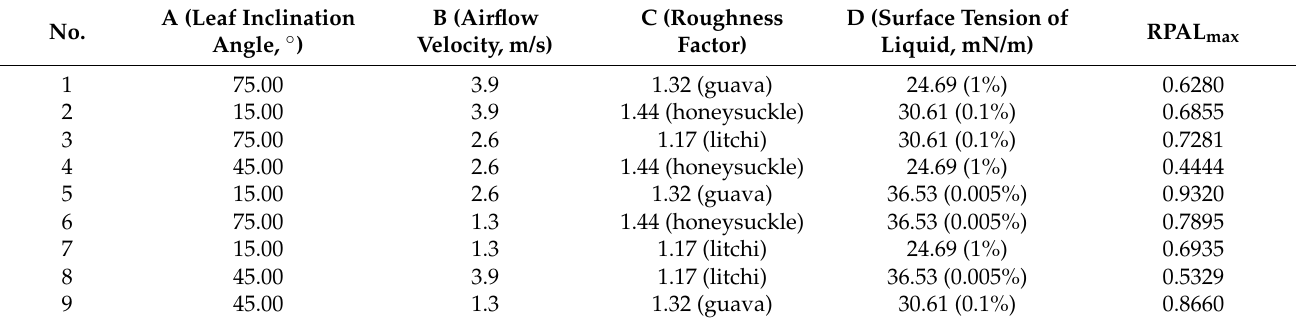
Figure 10. Effect of leaf type on droplet deposition under different spray volumes. The orthogonal experimental results are shown in Table 10. The experimental index was RPAL max , and SPSS was used to conduct non-repeated orthogonal experiment variance analysis. As seen in Table 8, all four factors had a significant effect on RPAL max . Table 10. Four factors and four levels orthogonal experiment results.